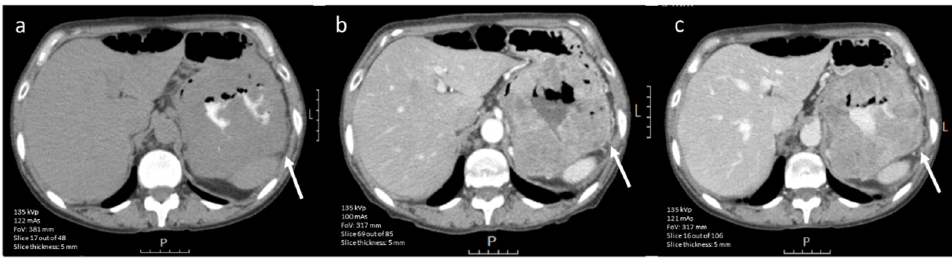
Figure 4. ( a – c ). Axial contrast-enhanced (iodinated contrast media) CT images of a 60-year-old male diagnosed with a (histopathologically confirmed) high-mitotic gastric GIST. The lesion (arrow) shows a lobulated tumor shape, heterogeneous enhancement in ( a ) nonenhanced phase, ( b ) arterial phase and ( c ) portal venous phase (scale bars 5 cm).